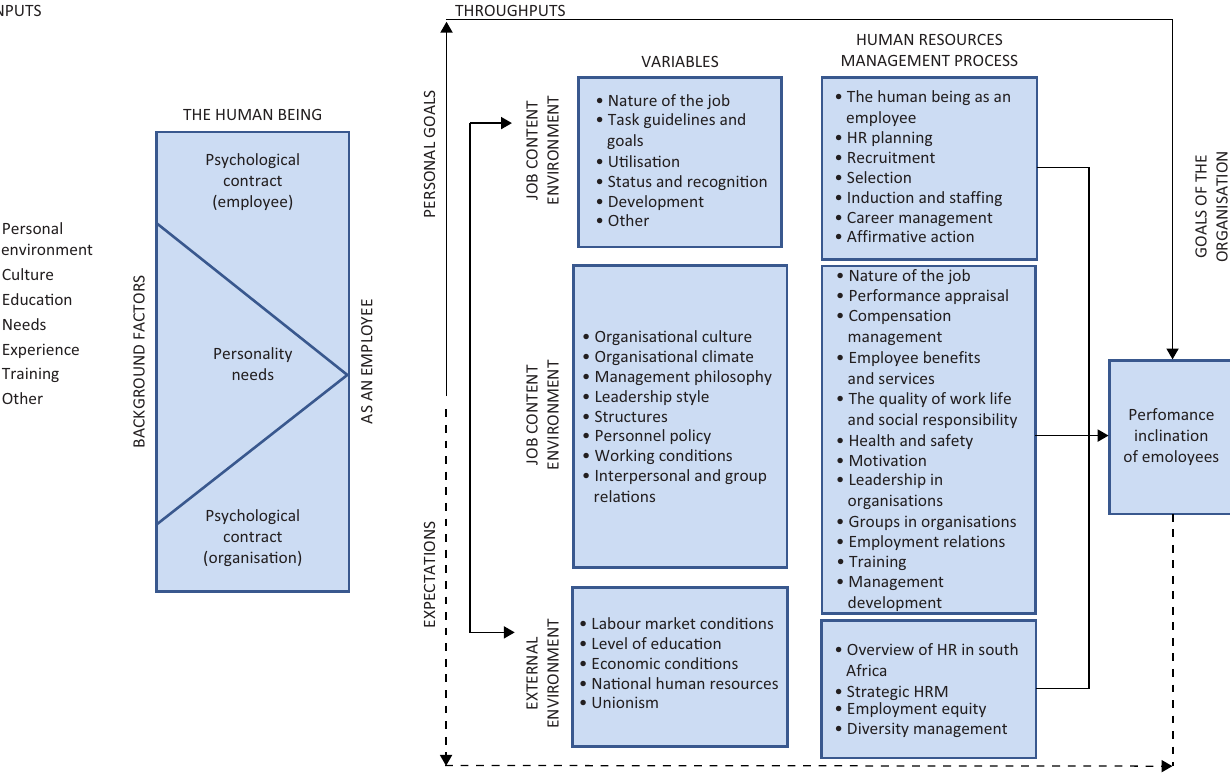
FIGURE 1: A management systems model of the employee as a